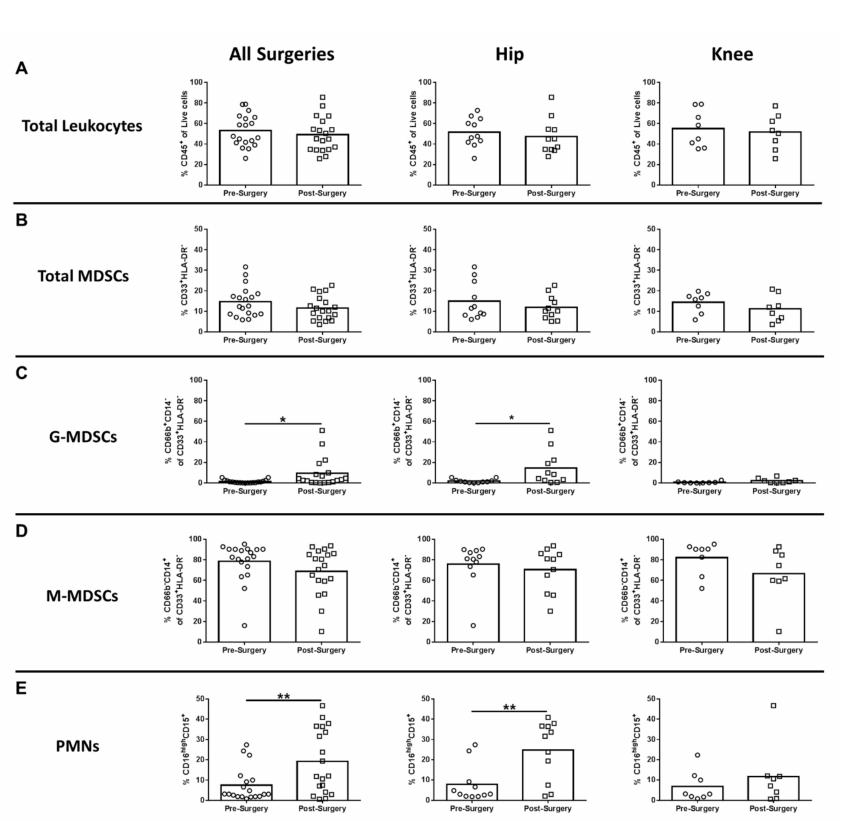
Figure 1. Hip / knee arthroplasty results in increased granulocytic myeloid-derived suppressor cells (G-MDSCs) and polymorphonuclear neutrophils (PMNs) in the peripheral circulation. Blood samples collected from patients pre- and post-surgery for total hip (THA) ( n = 11) and total knee arthroplasties (TKA) ( n = 8) were analyzed by flow cytometry. Results were calculated after gating on live CD45 + cells and quantitation of ( A ) total CD45 + leukocytes, ( B ) total myeloid-derived suppressor cells (MDSCs) (CD33 + HLA-DR - ), ( C ) G-MDSCs (% CD66b + CD14 - of the total MDSC population), ( D ) M-MDSCs (% CD66b - CD14 + of the total MDSC population), and ( E ) CD16 high CD15 + neutrophils (PMNs) is reported (* p < 0.05; ** p < 0.01; unpaired two-tailed Student’s t